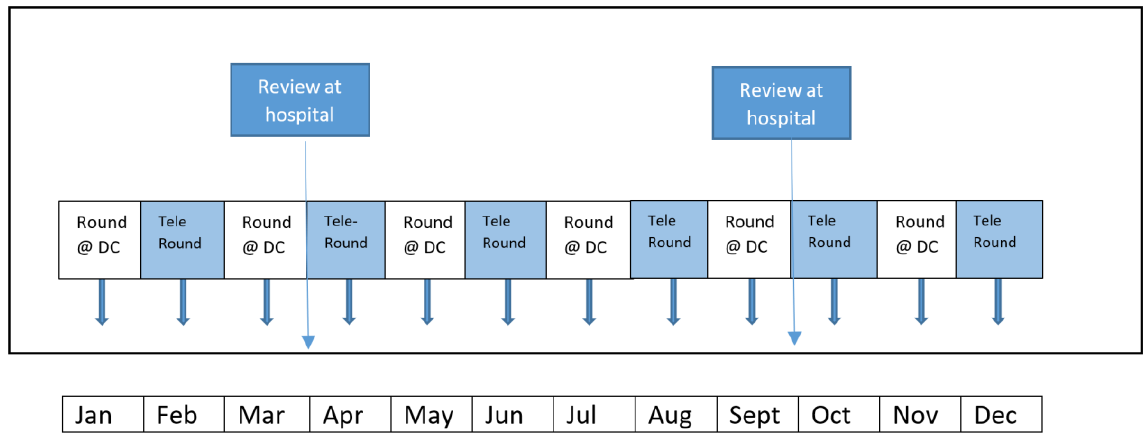
Figure 2. Structure of review at the dialysis unit since onset of the COVID-19 pandemic.